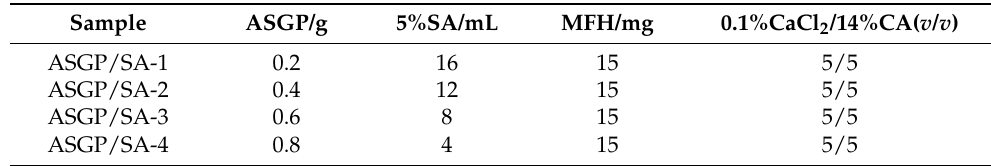
Table 2. Specific preparation parameters of hydrogels.